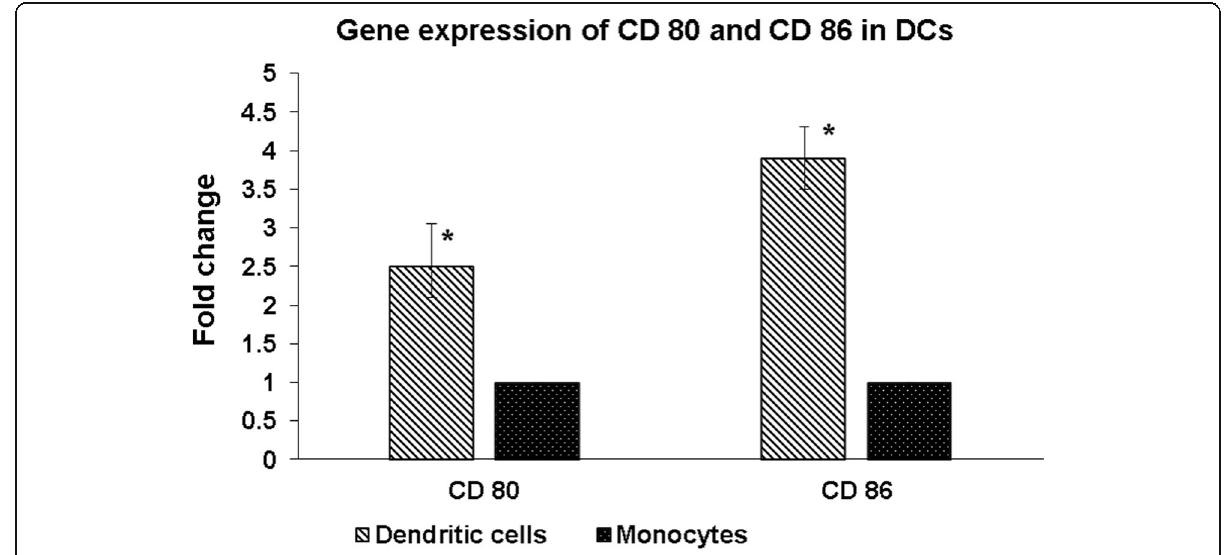
Fig. 4 CD80 and CD86 gene expression in dendritic cells showing significant upregulation for both markers in comparison with monocytes at day 0 ( P -value < 0.05). Each value is the mean of 3 experiments ±